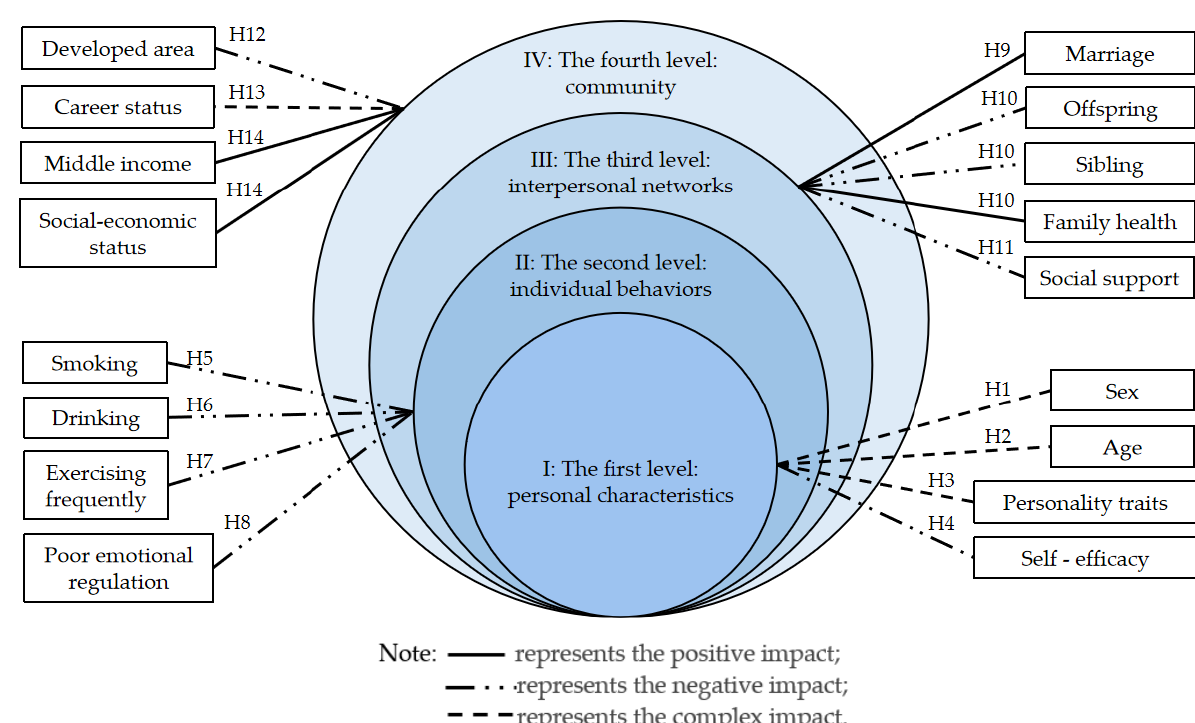
Figure 4. The influencing factors in the Ecological Model of Health Behavior. The predictive accuracy of the EBS-SF score in differentiating overweight and obesity was proven with all the AUC greater than 0.70.